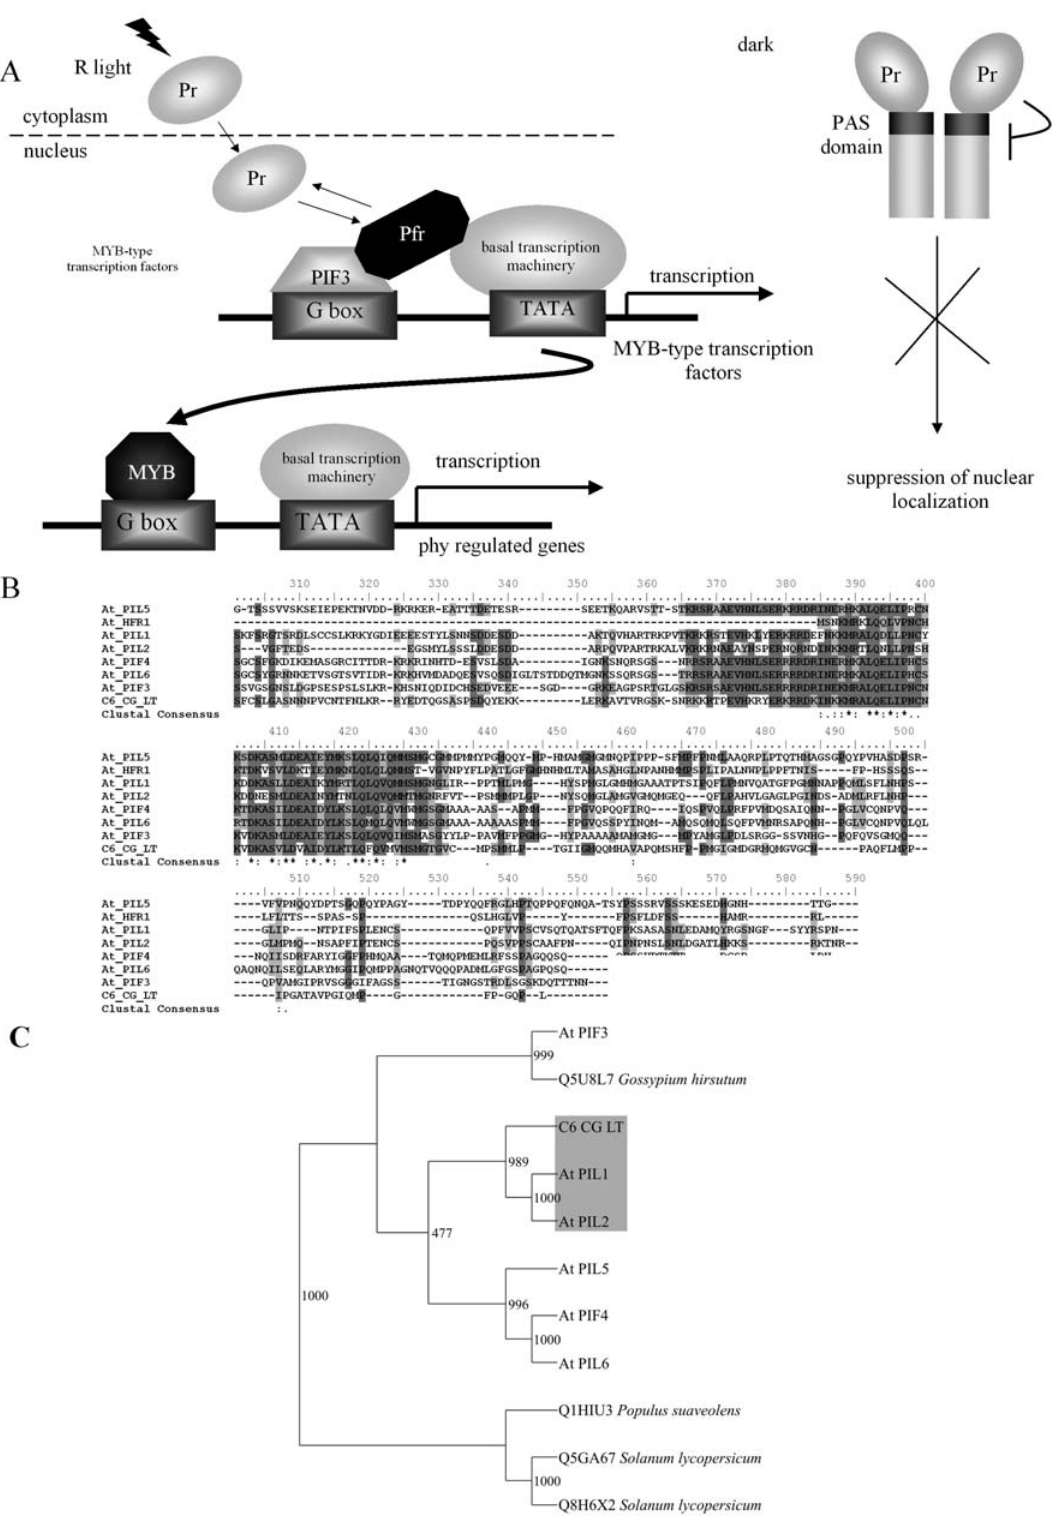
Figure 5 - Light-signaling associated bHLH transcriptional regulator family in citrus. A. schematic representation of phytochrome-regulated PIF3 transcriptional activation. B. alignment of the bHLH DNA-binding domainPIF/PIL family in Arabidopsis and citrus. C. phylogenetic analysis of plant PIF/PIL genes. Neighbor-joining trees for a concatenation of the DNA-binding amino acid domains aligned with ClustalX is shown. Bootstrap values are indicatedaboveeachbranch.Darkandlightgrayshadingindicatesequenceidentityandsimilarity,respectively.Thesequencesfromspeciesotherthan A. thaliana and citrus are indicated by their ExPaSy entry code. At, Arabidopsis thaliana ; bHLH, basic loop-helix-loop DNA binding domain; C Number, contig number; CG, Citrus aurantifolia; LT, Citrus latifolia